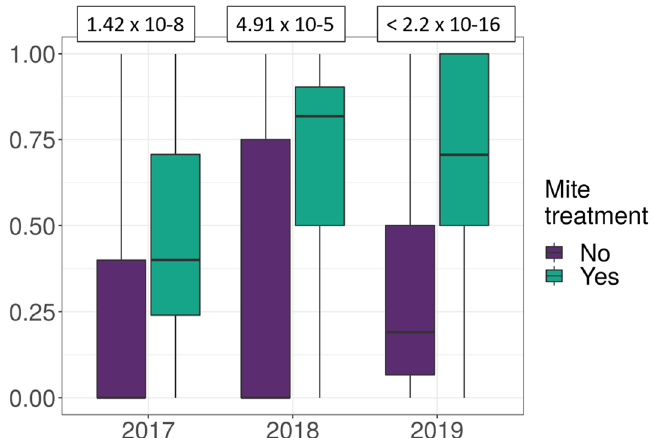
Figure 2. Survival of mite-treated and untreated honey bee colonies by year. In each of the three years, 80 out of 375 (21%), 25 out of 377 (7%) and 192 out of 974 (20%) colonies were untreated (297 out of 1,726, or 17% overall). In the white boxes the p-values results of the one-sided t-test for each year. Evidence rejects H0 in favor of H1: the average survival is higher when the colonies are